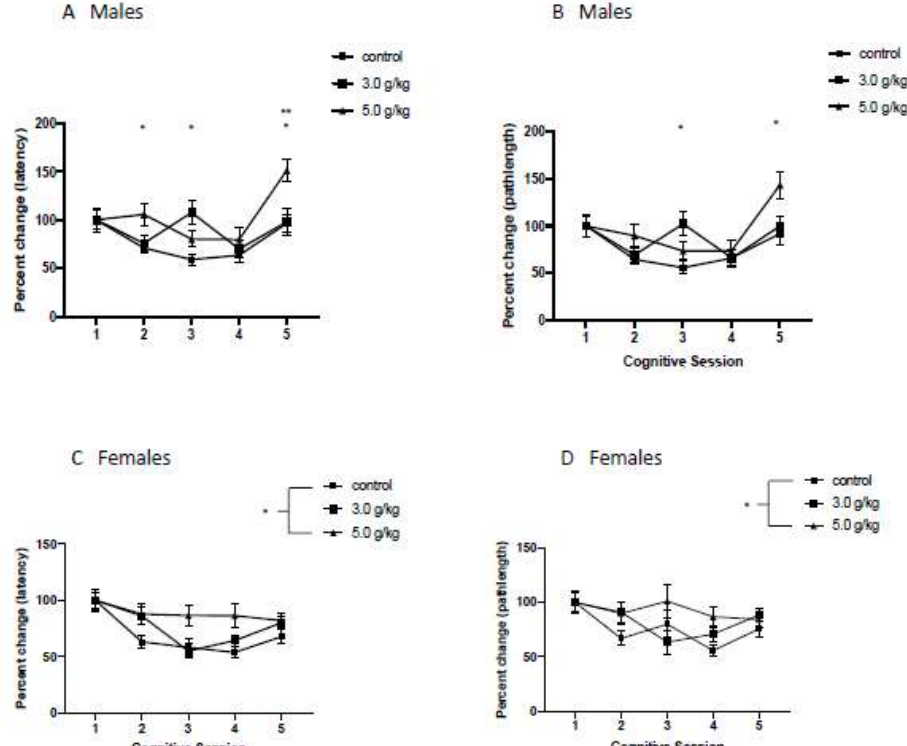
Figure 5. Chronic Intermittent Ethanol Exposure During Adolescence Impairs Behavioral Flexibility As a Function of Age. Percent performance on day 1 of behavioral flexibility testing for each cognitive session for males (subfigures A and B ) and females (subfigures C and D ) when measured by either latency to the platform (subfigures A and C ) or swimpath to the platform (subfigures B and D ). For males (subfigures A and B ) chronic intermittent ethanol interacted with age (as determined by later cognitive sessions) to impair behavioral flexibility performance. * and ** denotes significant difference within each cognitive session, ** p < 0.01; * p < 0.05; exact values provided in manuscript. For females (subfigures C and D ), animals treated with 5.0 g/kg ethanol had significantly worse behavioral flexibility compared to control animals. * p < 0.05; exact values provided in manuscript. Error bars denote standard error of the mean. A value above 100% indicates impaired performance relative to performance in CS1 while a value below 100% indicates improved performance relative to performance in CS1.